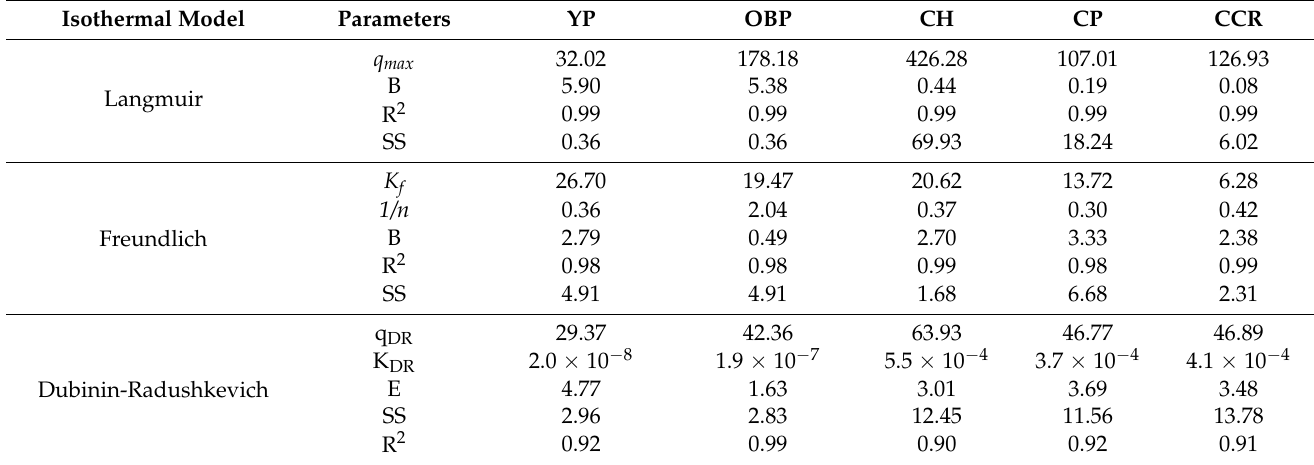
Table 5. Adsorption isotherm parameters of the Langmuir, Freundlich and Dubinin-Radushkevich’s models of Cd 2+ adsorption onto YP, OPB, CH, CP and